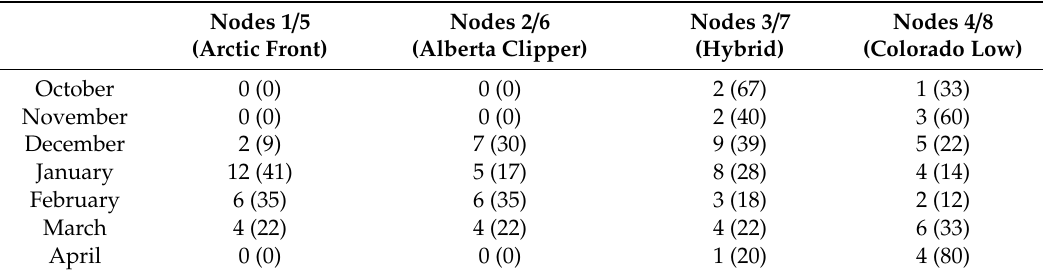
Figure 11. Percent of ( a ) Colorado Low, ( b ) Alberta Clipper, ( c ) Hybrid, and ( d ) Arctic Front blizzards identified within each of the eight SOM nodes. Table 2. Number (Percentage) of blizzards segregated by month and SOM nodes. Percentages are calculated using monthly